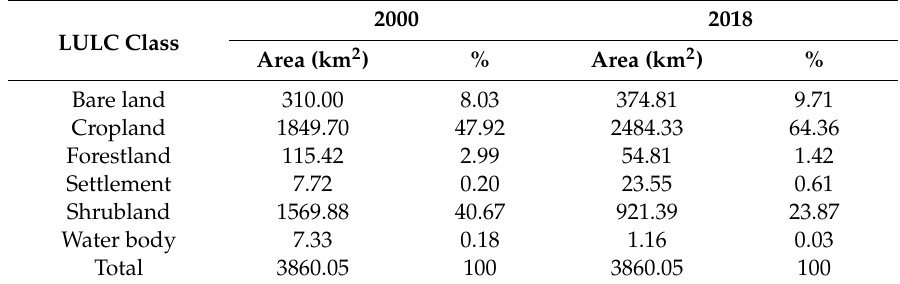
Table 2. Areal statistics of classified land use and land cover change (LULC) classes for 2000 and